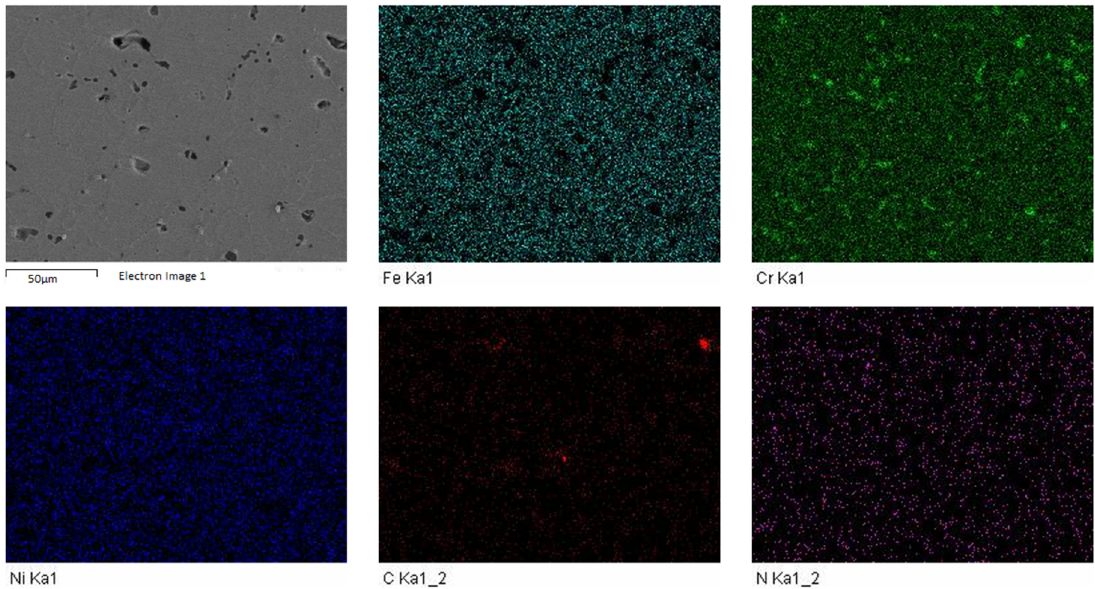
Figure 4. FESEM-EDS elemental maps for pure 316L stainless steel specimens.